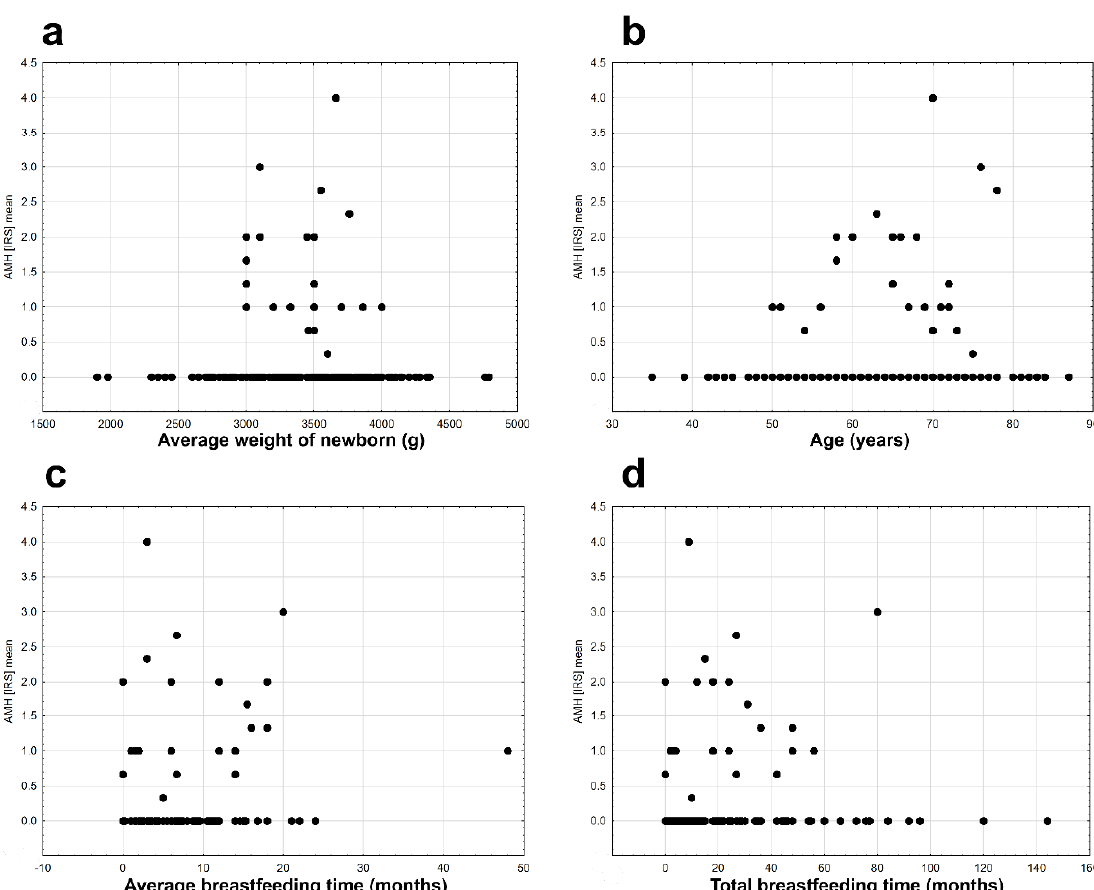
Figure 4. Mean AMH expression due to: ( a ) the weight of newborn (s) (r s = − 0.054, n = 207, p = 0.440); ( b ) age of the patient (r s = − 0.116, n = 232, p = 0.077); ( c ) mean breastfeeding time (r s = − 0.163, n = 229, p = 0.014); ( d ) total breastfeeding time (r s = − 0.134, n = 229, p = 0.042).